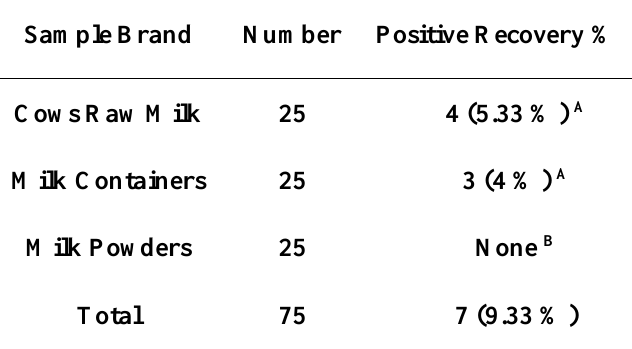
Table 1. Recovery of E. faecalis from total brands samples